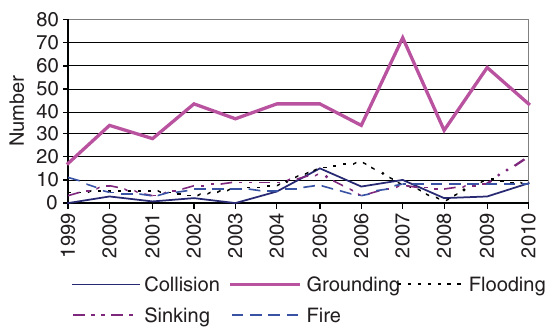
Fig. 1. Five main causes of ship accidents on the east coast of the Adriatic (Statisticˇki Podaci SAR 2010)